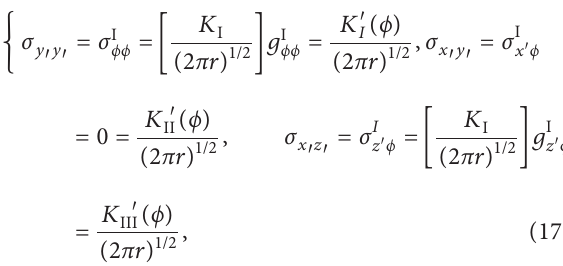
Figure 10: A comparison diagram between the paper [43] and numerical simulation of fracture path. (a) Pure mode I with α � 0 ° ; mixed mode I/III with (b) α � 30 ° , (c) α � 45 ° , (d) and α � 60 °